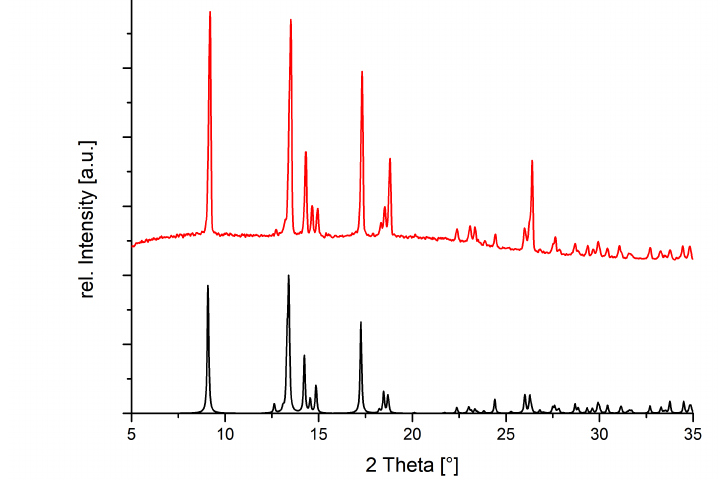
Figure 8. Measured (red) and calculated (black) powder diffraction pattern for 2b